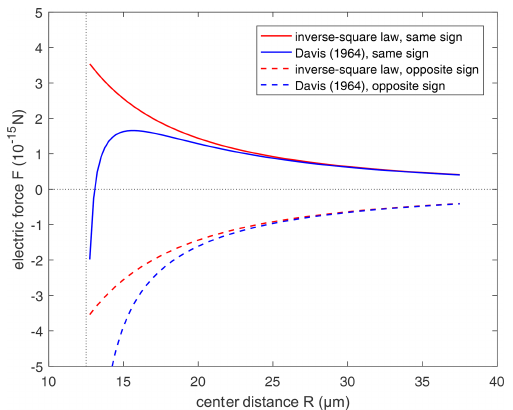
Figure 3. Comparison of the electric force from the conductor model (Davis, 1964; Eq. 15 in this study) and the inverse-square law (Eq. 12 in this study). Positive force represents repulsion and negative force represents attraction. Radius of the pair is set to r 1 = 10µm and r 2 = 2 . 5µm, respectively. Solid lines are for the droplet pair with the same sign of electric charges, with q 1 = + 100 e and q 2 = + 25 e . Dashed lines are for droplets with the opposite sign of electric charges, with q 1 = + 100 e and q 2 = − 25 e